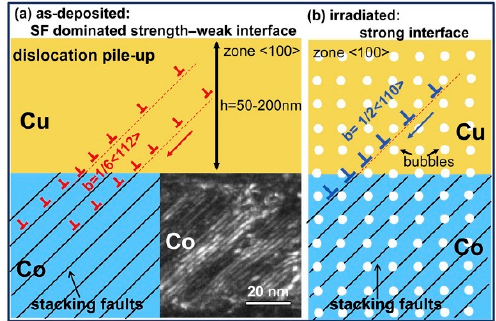
Figure 21. Hypothetical schematics illustrate different strengthening mechanisms in as-deposited and irradiated Cu/Co (100) multilayers at large h (h = 50–200 nm). ( a ) In the as-deposited state, partial dislocations can transmit across the Cu/Co interface relatively easily; ( b ) After radiation, high-density He bubbles are distributed both along the layer interface and within the layers [56].